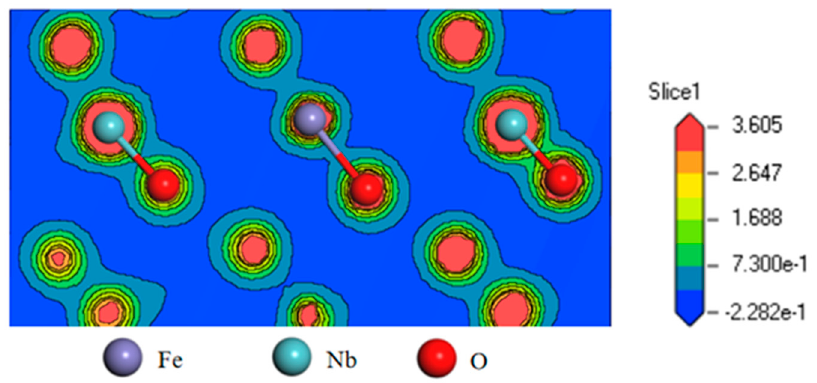
Figure 6. Charge density diagram of FeNb 2 O 6 (110).